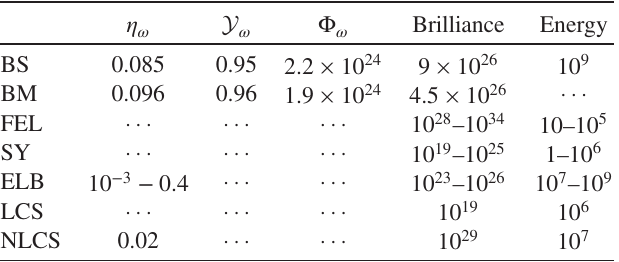
TABLE I. Beamstrahlung γ rays source, simulation (BS)